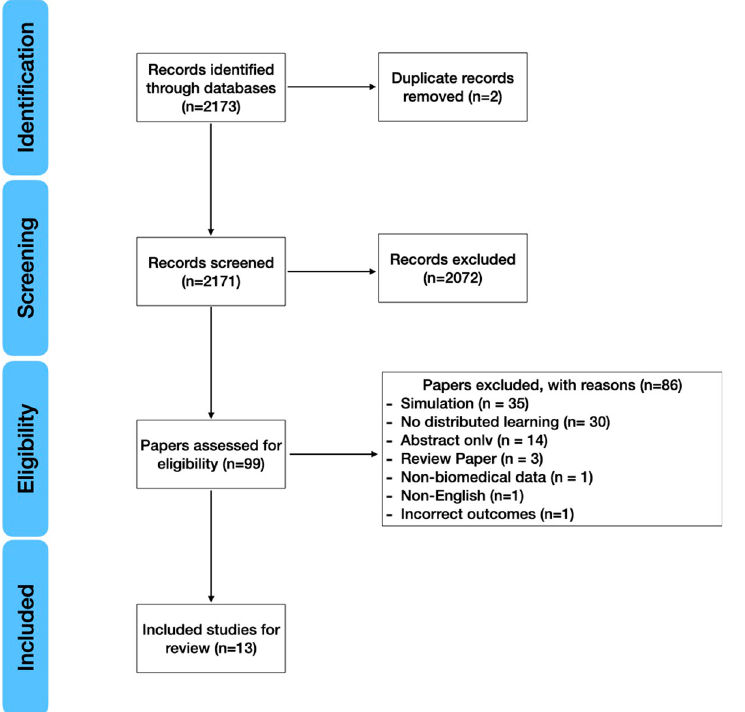
Fig 1. Study inclusion and exclusion